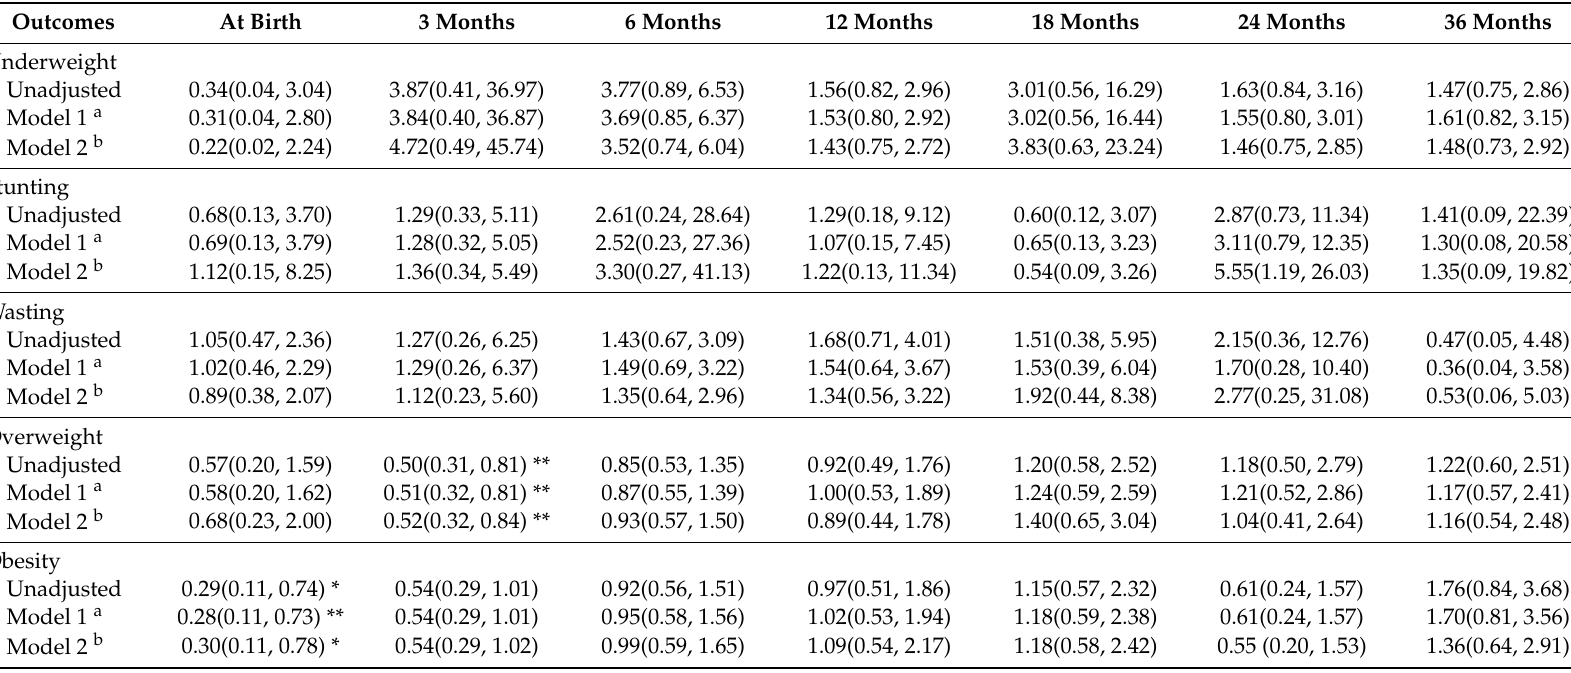
Table 4. E ff ects of maternal prenatal multi-micronutrient supplementation compared with iron–folic acid supplementation on nutritional status at di ff erent age points. Outcomes At Birth 3